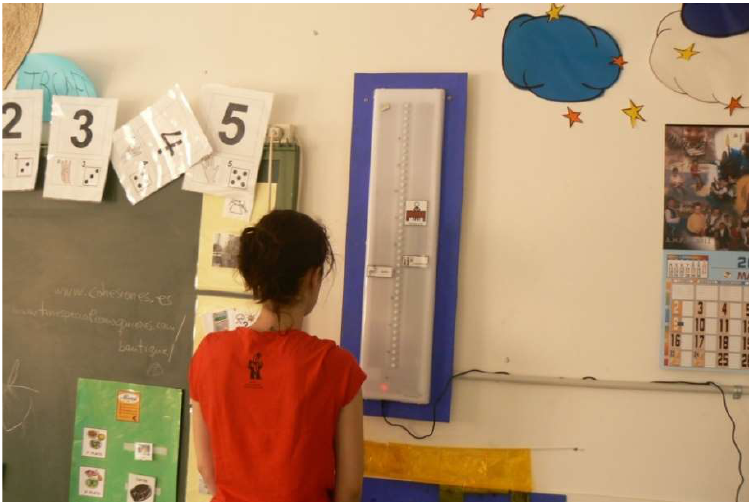
Figure 8. TOD without screen installed in a classroom, with lights off.